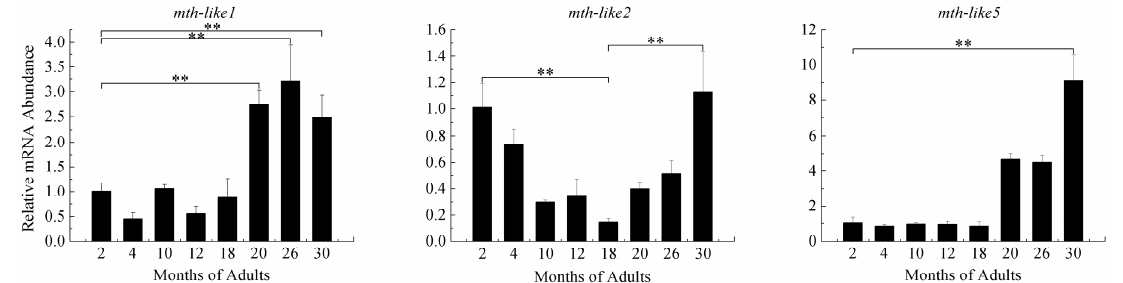
Figure 5. Expression of mth ‐ like genes in different groups of adults (aged 2, 4, 10, 12, 18, 20, 26, and 30 months). The relative expression indicates the level of each mth ‐ like transcript normalized to the internal standard of α‐ tubulin, compared to expression level of the first group (two ‐ months). Data are shown as the mean ± SD. Asterisks indicate differences that are statistically significant (*, p < 0.05).